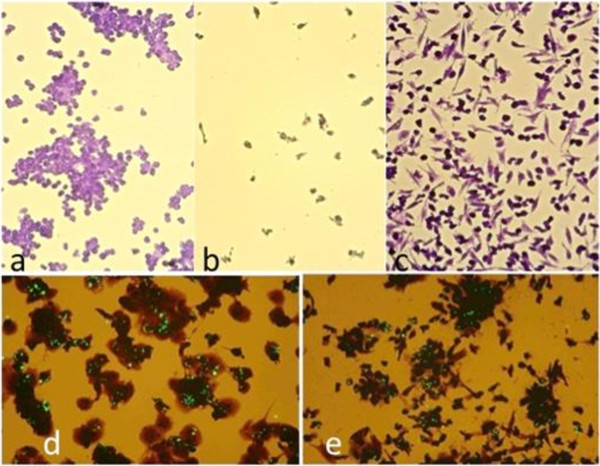
THP-1 cells cultivated for 24 h with PMA (a), no addition (b) and 1 mg/mL A. bisporus polysaccharide extract (c); comparison of phagocytotic activity after PMA treatment (d) and A. bisporus polysaccharide extract treatment (e). Cells were cultivated in a 24 wells plate, washed with PBS, fixated in 4% formaldehyde and stained by crystal violet. Figure 
1a shows that PMA treated cells form aggregates after 24 h incubation and adhere to the plate. Figure 
1b shows that non treated control cells do not adhere and are washed away. Figure 
1c shows the effect of A. bisporus polysaccharide extract, stretching of the originally rounded cells, and adherence to the plate. Figure 
1d shows the uptake of fluorescent latex particles in PMA treated THP-1 cells and Figure 
1e shows uptake of particles in A. bisporus polysaccharide extract treated cells.